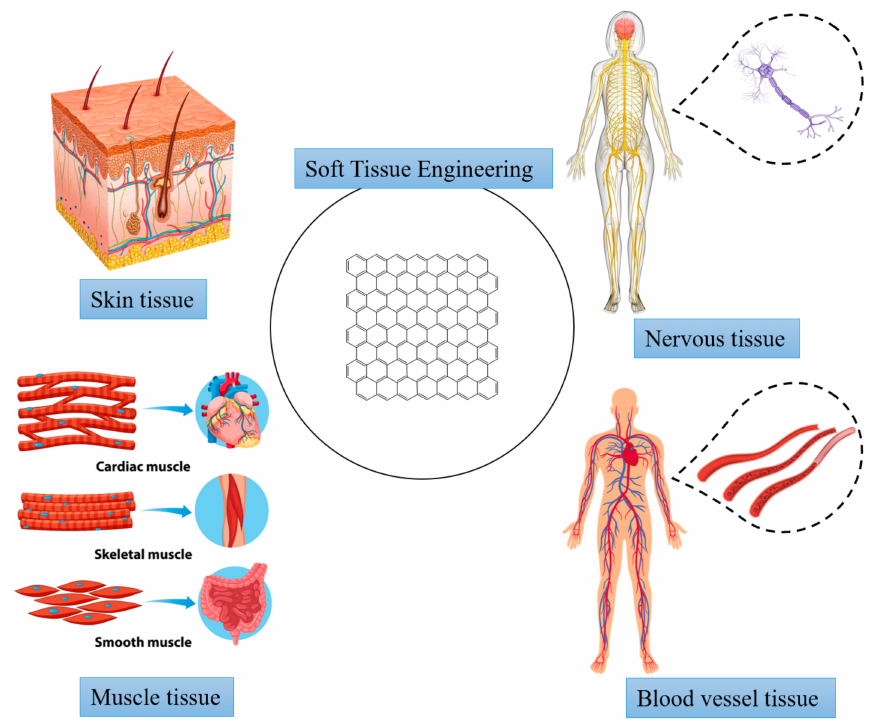
Figure 4. Applications in soft tissue